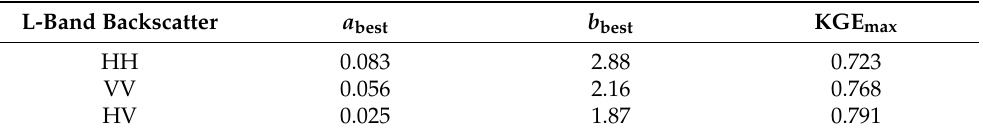
Table 2. Regression model parameters for estimating the effective s -values for the Oh model from normalized backscatter